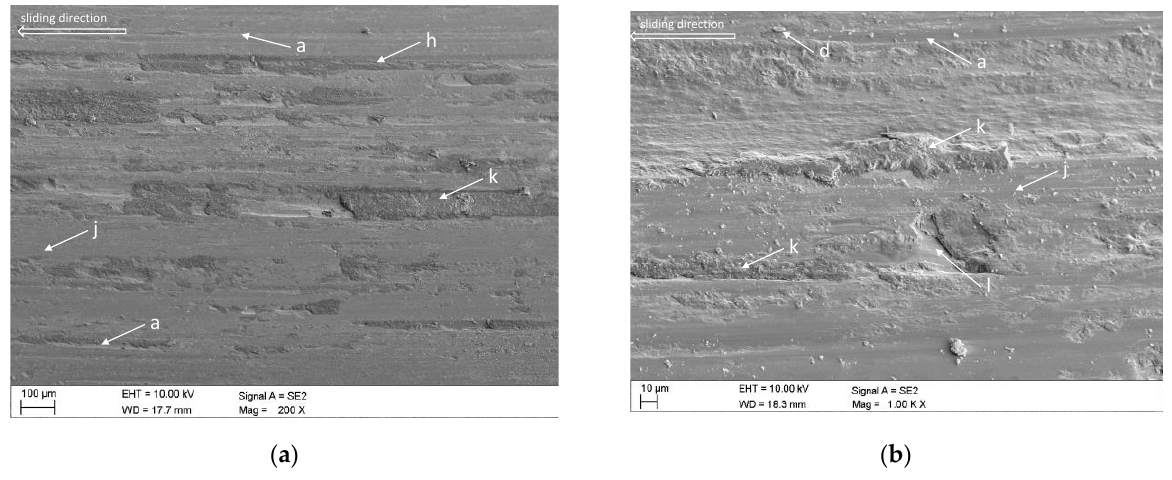
Figure 13. Views of WRS_400_I steel (a, b) after the tests without using the abrasive (Variant VI), SEM; symbols: a—grooves, h—coal-filled sanding marks, j—smoothing the surface, k—corrosion products, l –gap.